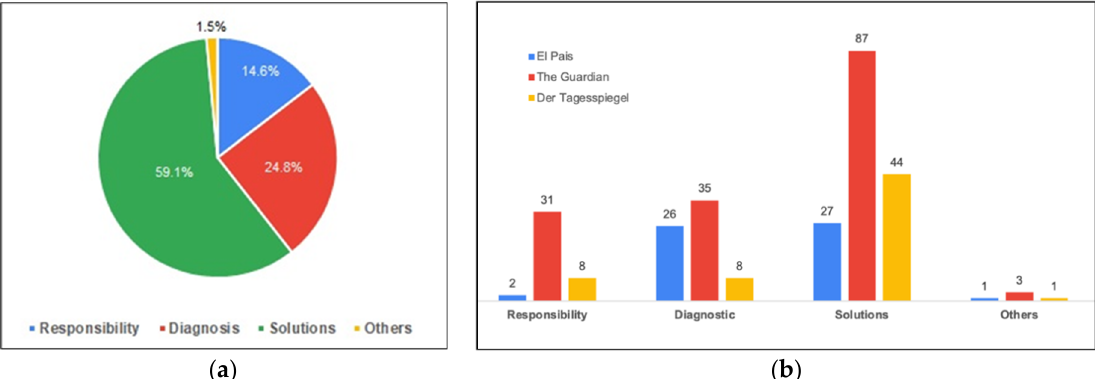
Figure 5. ( a ) Percentage of news by group of frames included in the general sample; ( b ) percentage of items published by media outlet in each big frame (%).